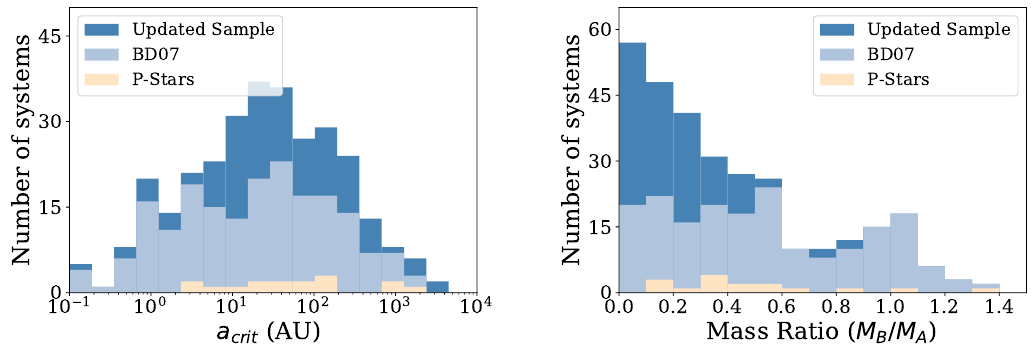
Figure 4. Histogram of the critical semi-major axis ( a crit , left panel ) and mass ratio ( M B / M A , right panel ) for the pairs in the updated (dark blue) and the original (light blue) UD binary sample. The number of stars with planets (P-Stars) in the final sample is shown in light